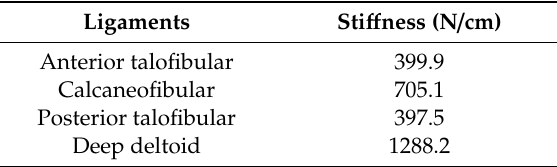
Table 3. Properties of ankle joint